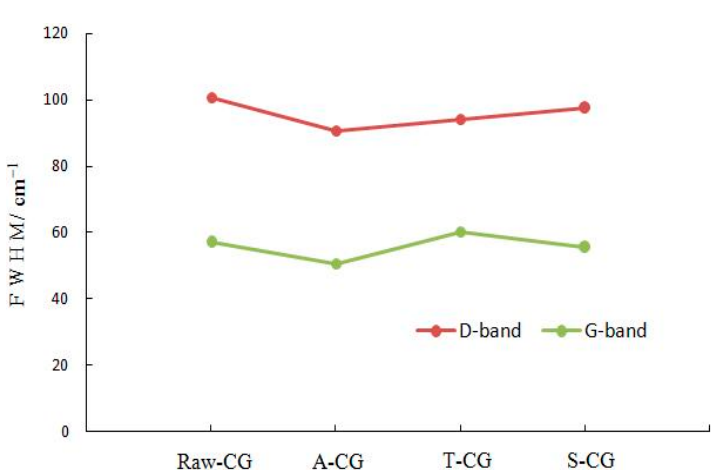
Figure 9. Raman spectrum of coal gangue sample.